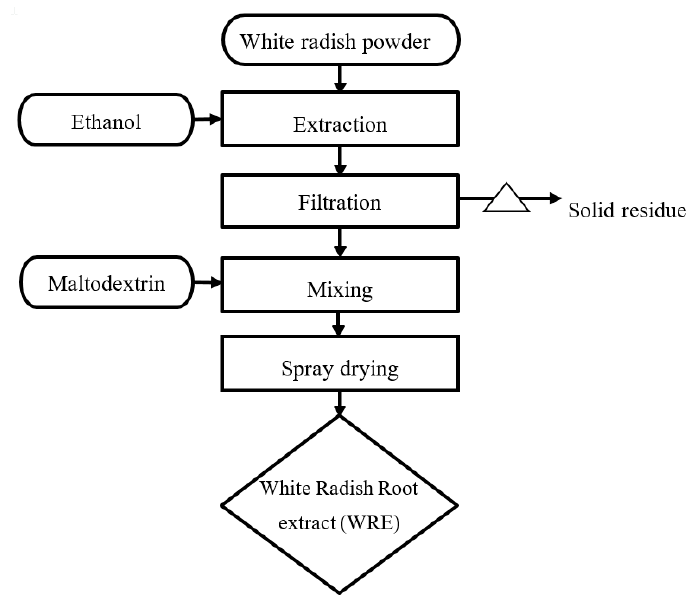
Figure 1. The procedure for the preparation of White Radish Extract (WRE). Processes 2019 , 24 , x FOR PEER REVIEW